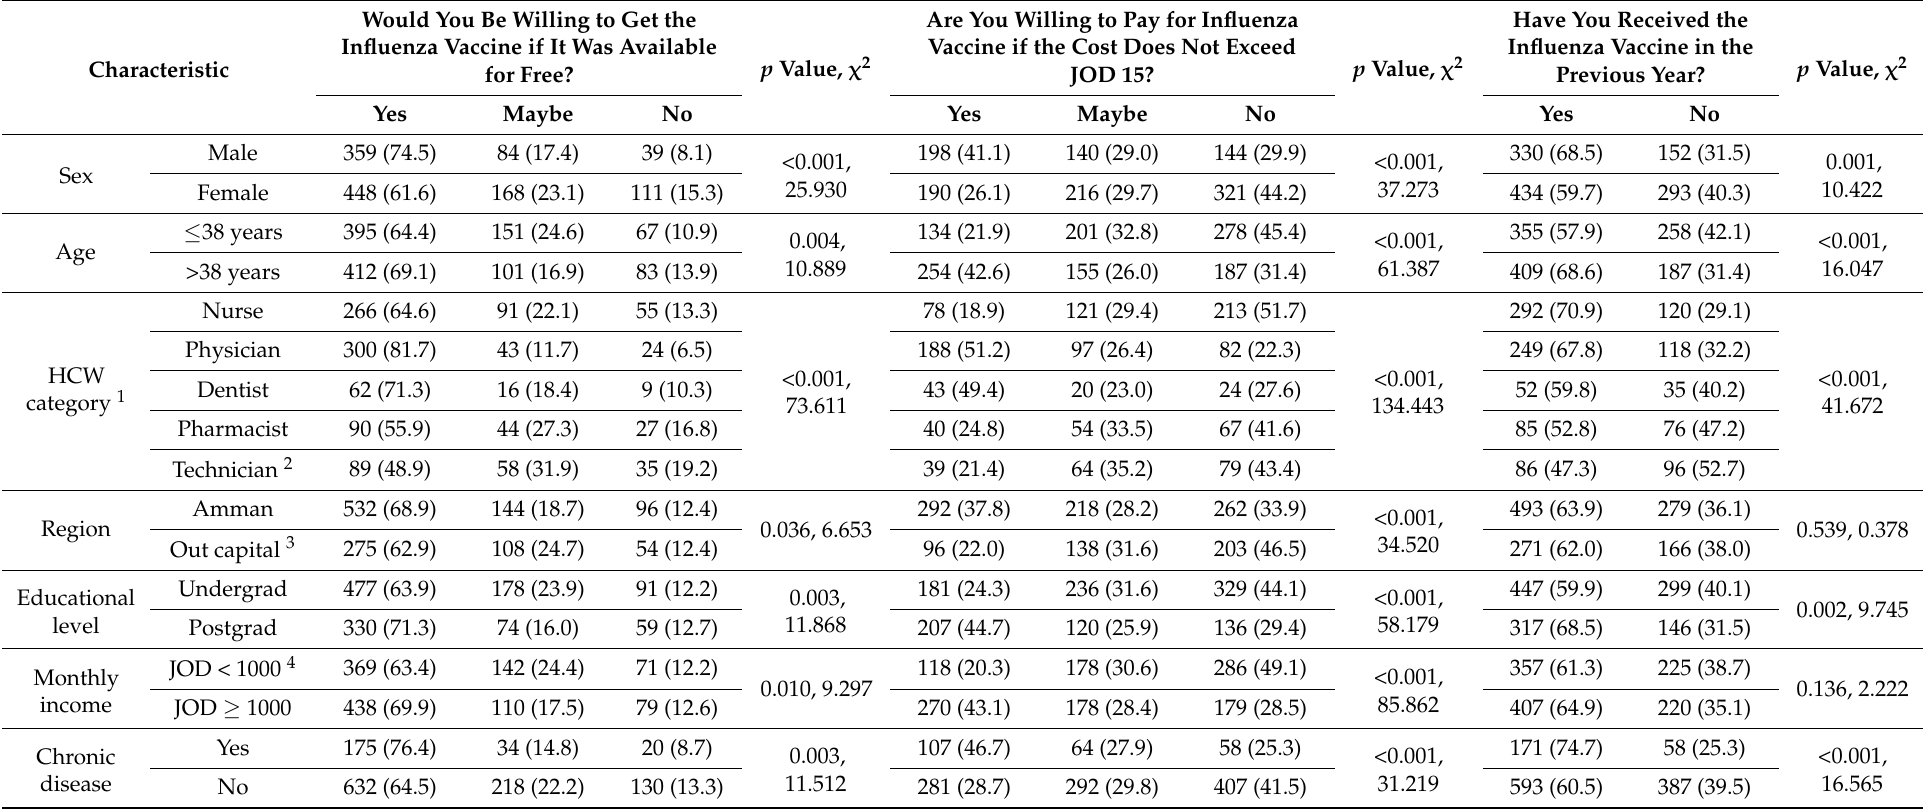
Table 3. Characteristics of the study sample divided by attitude/practice with respect to influenza